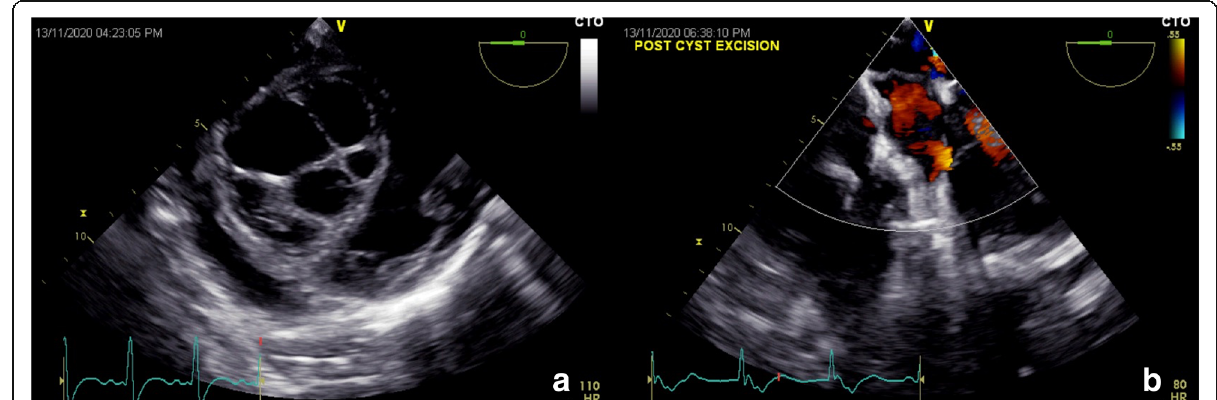
Fig. 4 a Intraoperative transesophageal echocardiogram showing multilocular hydatid cyst over the interventricular septum. b Post-excision images showing complete removal of the